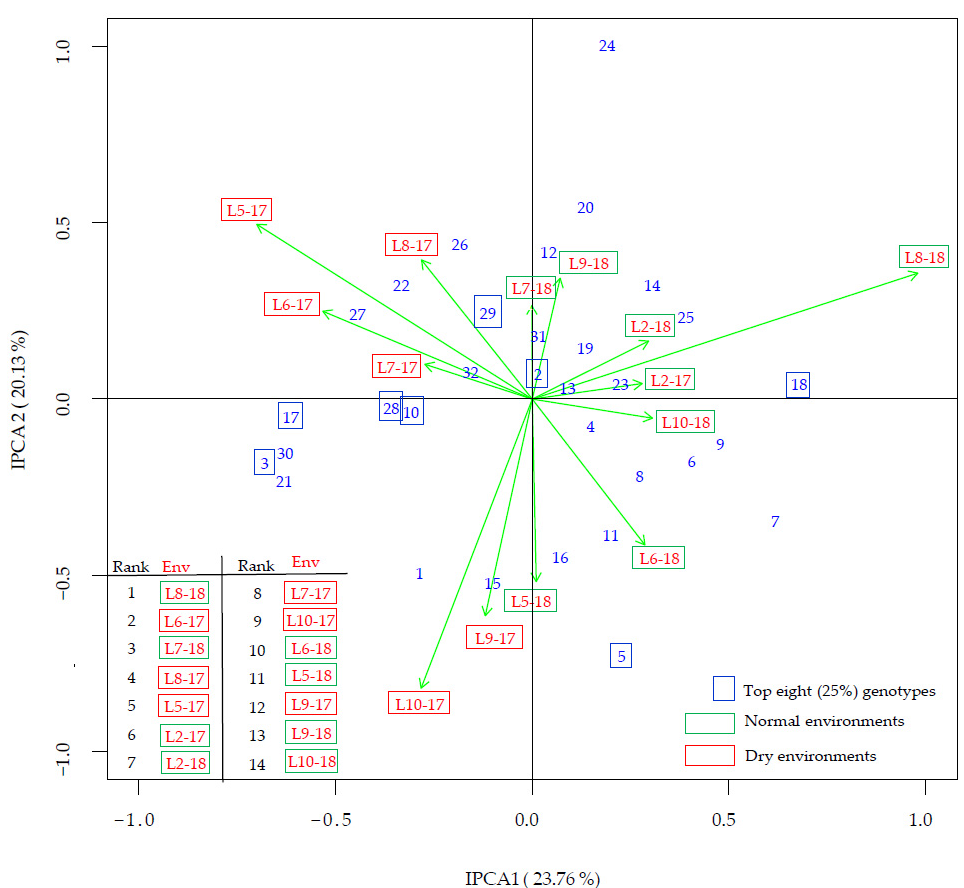
Figure 4. AMMI 2 biplot of 32 soybean genotypes tested in 14 environments (combination of seven locations with two cultivation years) for oil content.